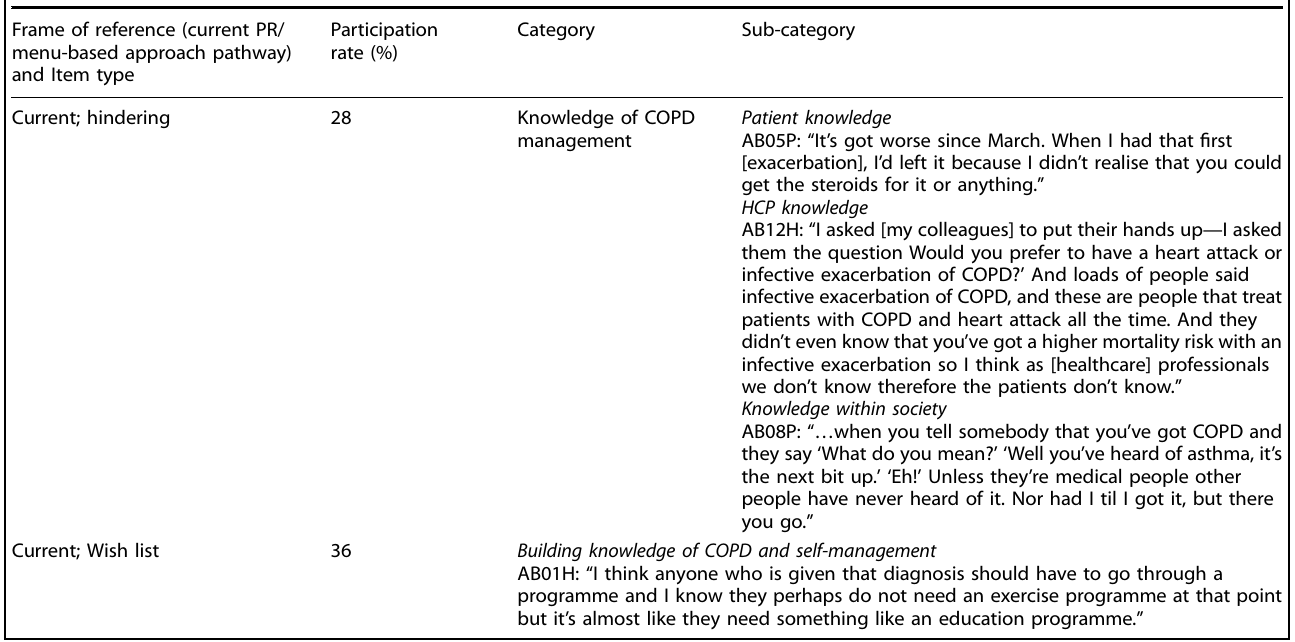
Table 2. Understanding